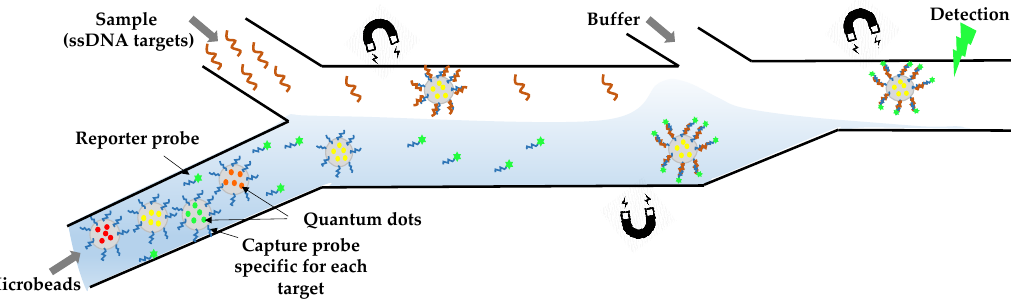
Figure 5. Overall design of the QD barcode assay. Electrokinetics is used to transport QD-barcoded microbeads (Ø = 3.8 µ m) into a microchannel. The flow is going from left to right: (i) magnetic barcodes are attracted by a first magnet to interact with the target ssDNA present in the upper stream, (ii) then they move toward the second magnet to interact with the reporter probe present in the lower stream, and (iii) they are pulled by the last magnet into a washing bu ff er and aligned for optical excitation and detection. They are individually detected by fluorescence as they pass through a focused laser spot. The figure shows the detection of one genetic target, but for multiplexed detection, the same process is done for the di ff erent ssDNA targets simultaneously